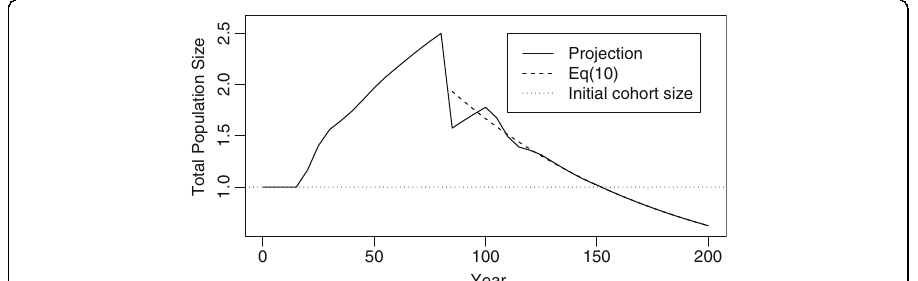
Fig. 1 The total size of a cohort and its descendants, by projection and by Eq. (10), for NRR=0.75 and mean age of fertility of 29